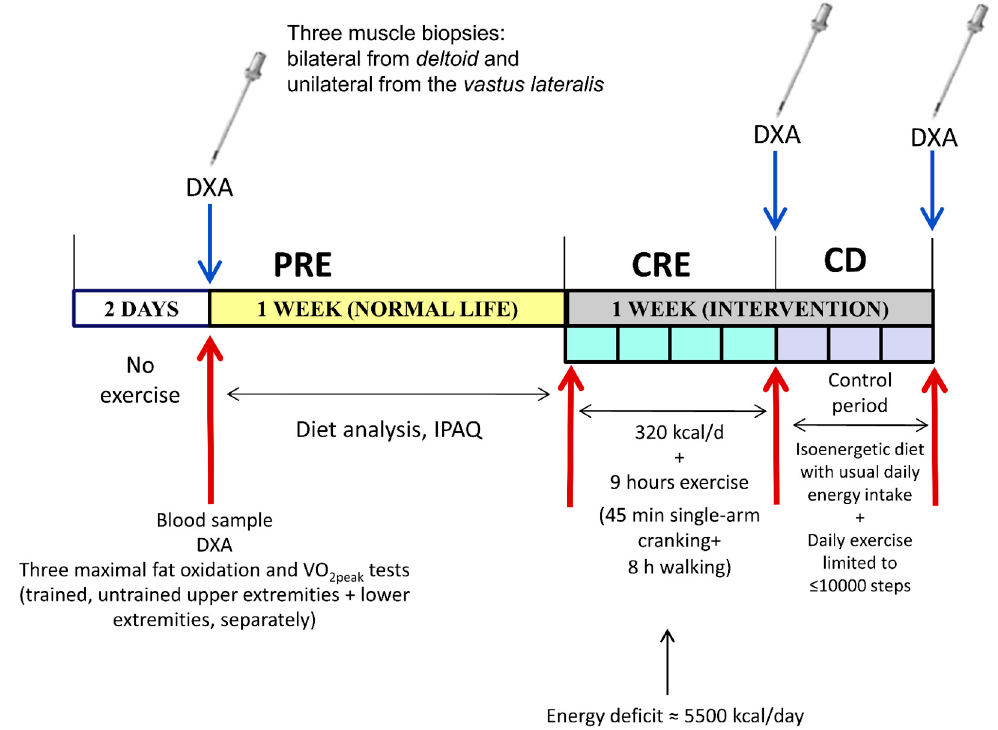
Figure 1. Schematic representation of the three phases of the intervention. PRE, before the intervention; CRE, four days of concomitant caloric restriction (3.2 kcal/day) and exercise (45 min of single-arm cranking and 8 h of walking each day); CD, three days on a diet isoenergetic to PRE phase with exercise limited to <10,000 steps per day; DXA, dual-energy X-ray absorptiometry; and IPAQ, International Physical Activity Questionnaire.